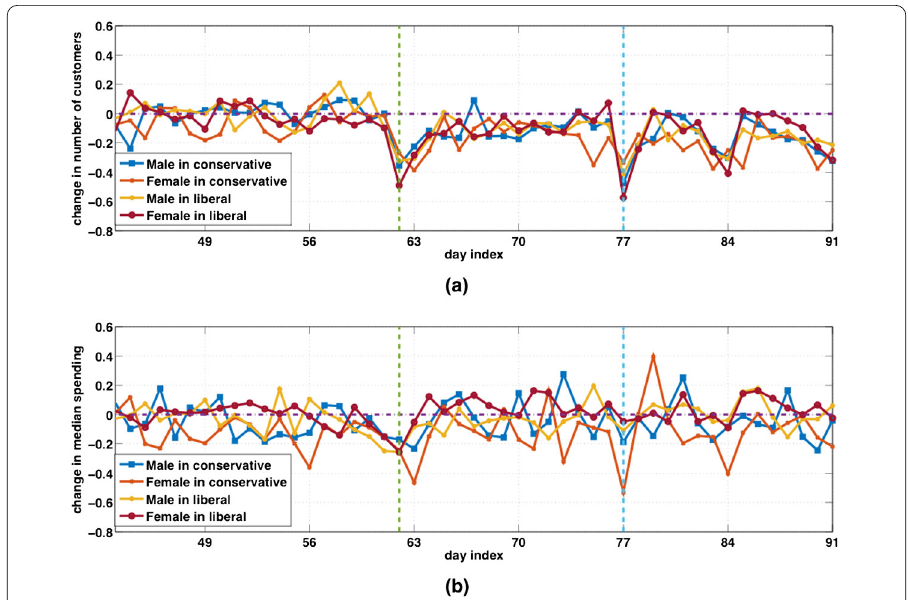
Figure A5 The impact of a series of protest events for male customers in conservative neighborhoods (blue), female customers in conservative neighborhoods (red), male customers in liberal neighborhoods (orange), and female customers in liberal neighborhoods (magenta): ( a ) number of customers; ( b ) median spending. The dash-dot purple line indicates zero change, and the dashed green and cyan lines indicate Day 62 and Day 77,